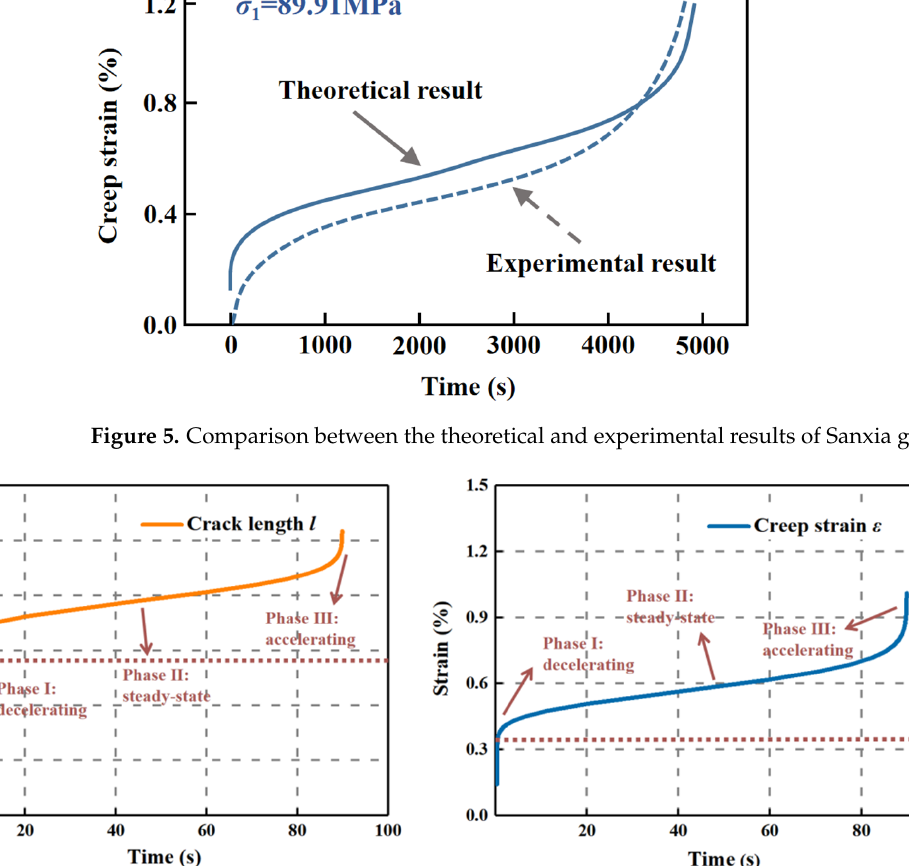
Figure 5. Comparison between the theoretical and experimental results of Sanxia granite [41].